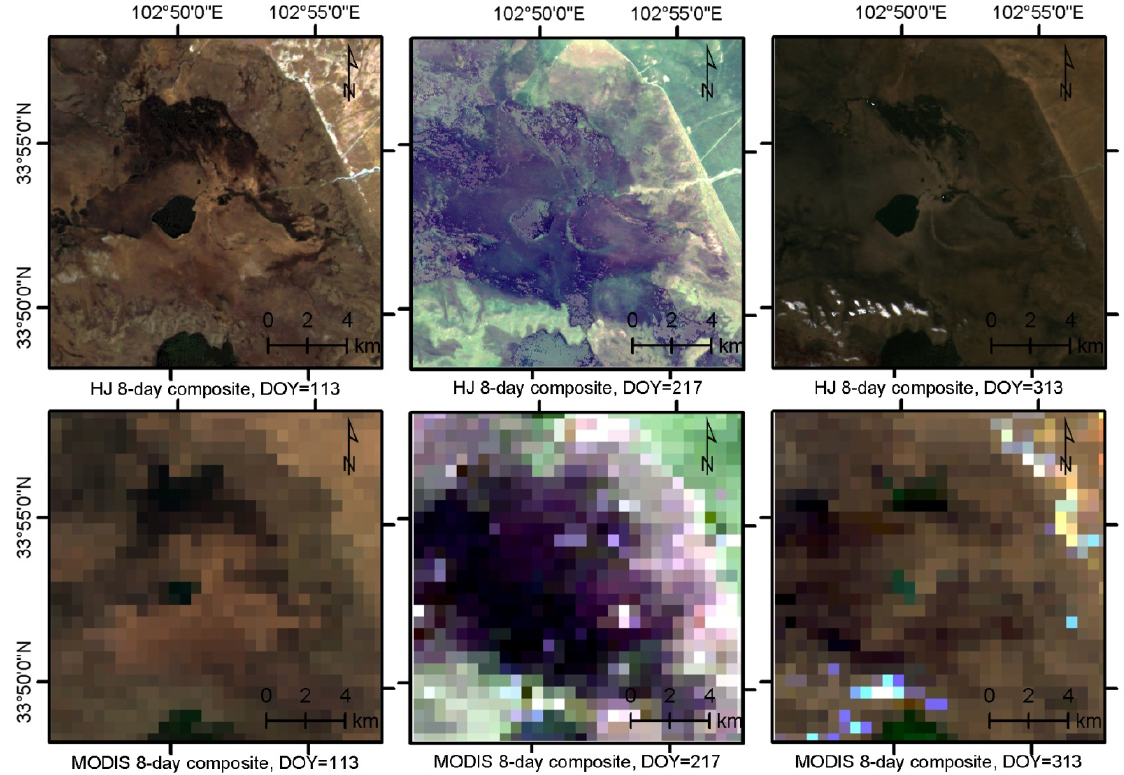
Figure 10. Comparison between the enlarged details of 8-day composited HJ-1A/B TOA reflectance ( upper ) and the 8-day MODIS MOD09A1 surface reflectance product ( lower ). The HJ-1A/B composites are shown with bands 3, 2, 1 and the MODIS MOD09A1 are shown with bands 1, 4, 3 in red, green and blue.